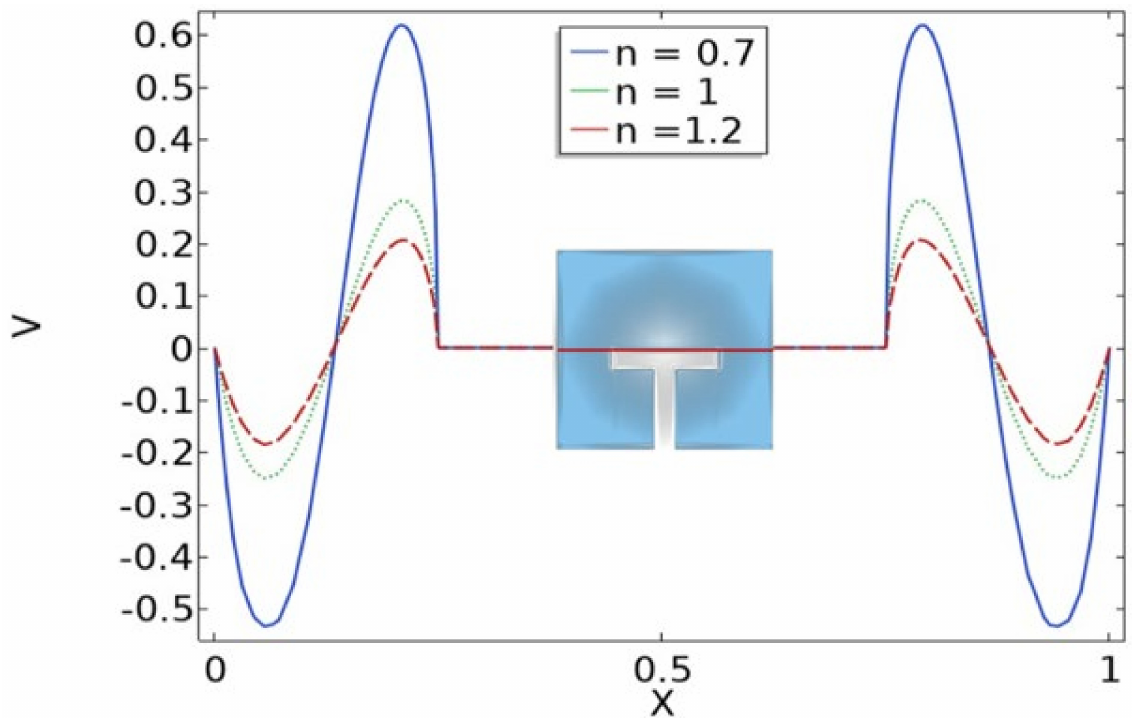
Figure 11. Cutlines for V at Y =